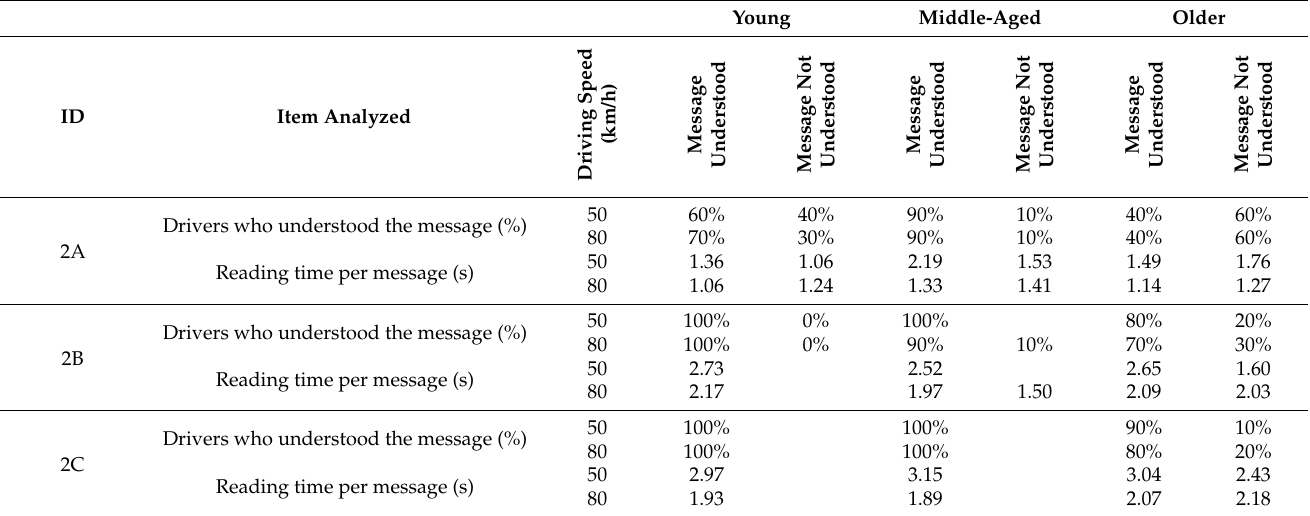
Table 5. Numerical results for Group 2—use of familiar pictograms. Young